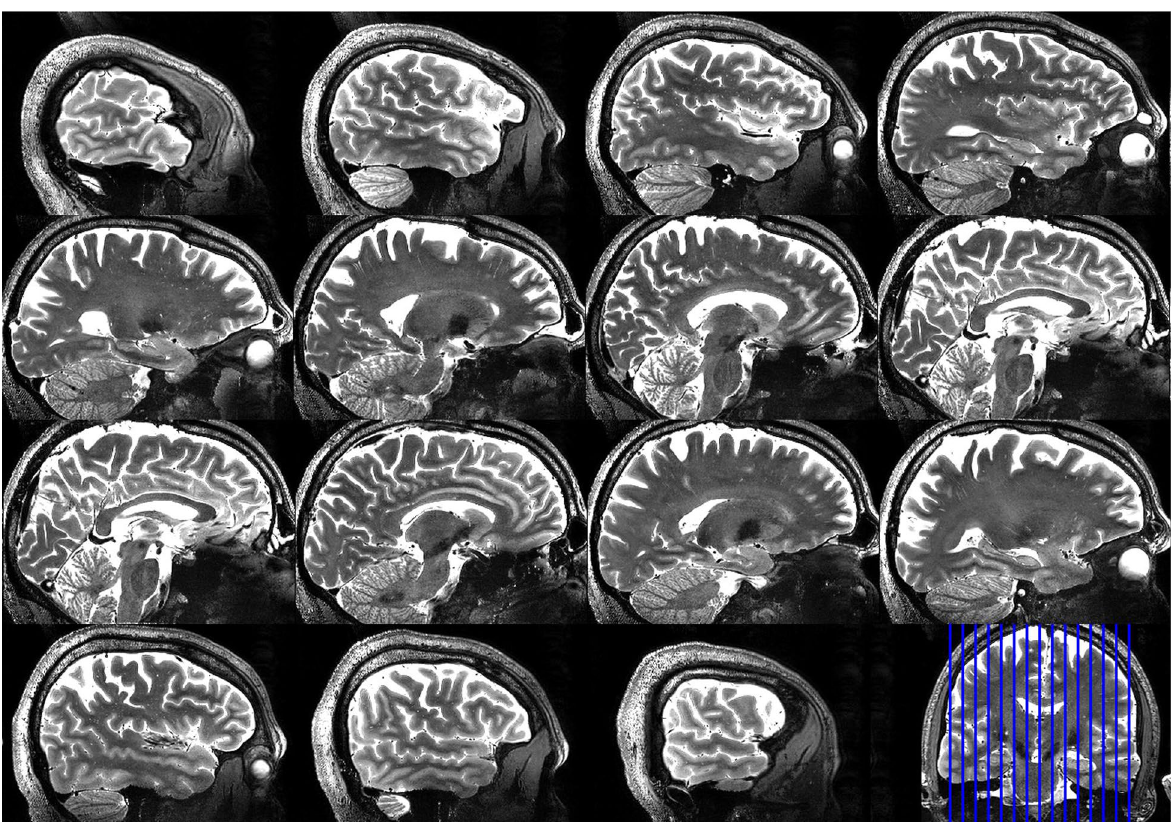
Figure 7. Sagittal slices of the 3D-SPACE acquired at 0.6 mm isotropic resolution, showing full brain and cerebellum coverage in a volunteer with large head size (~ 205 mm in anterior–posterior direction measured from the forehead). The images were obtained using the B 1 + homogeneous RF shim case on the sTx mode. The parameters of the acquisition were: TE/TR = 369/3400 ms, acceleration factor 3, BW = 488 Hz/Px, transversal acquisition of 224 slices, field of view 192 × 165.6 mm 2 in axial plane, and acquisition time = 8:11